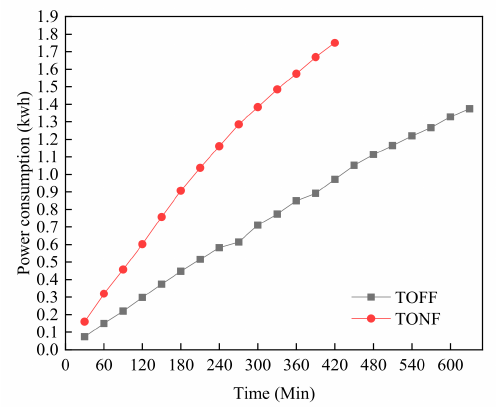
Figure 10. Changes of carrot drying power consumption over